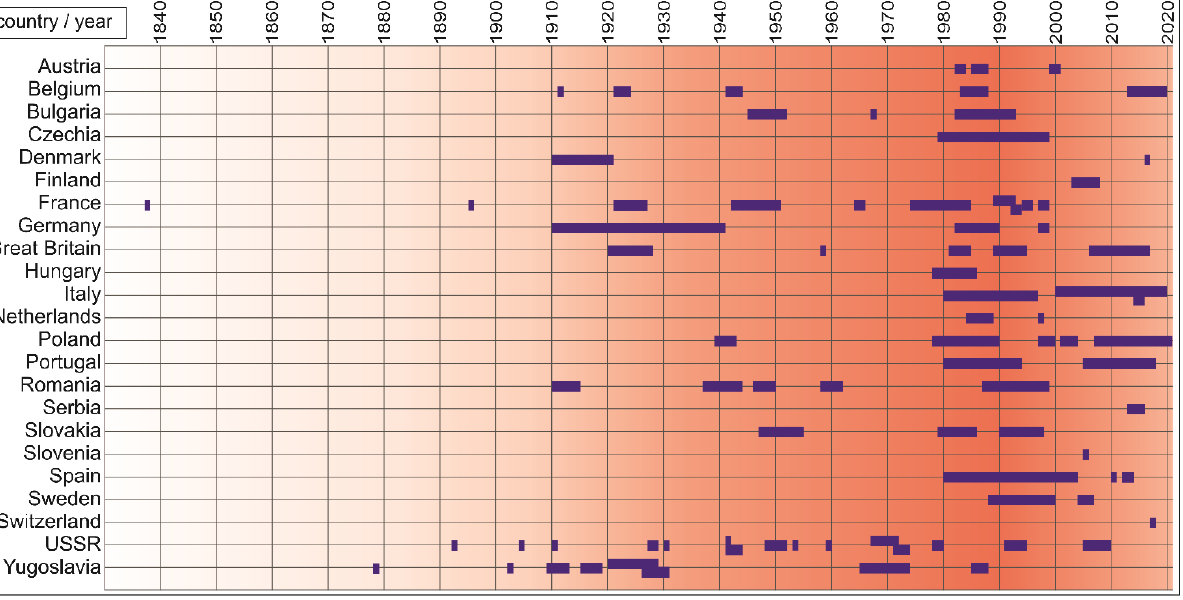
Figure 1. Timescale of oak decline episodes in European countries (according to [1 –